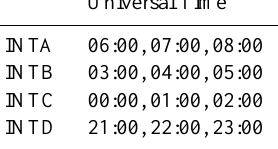
Table 1. Subdivisions. .